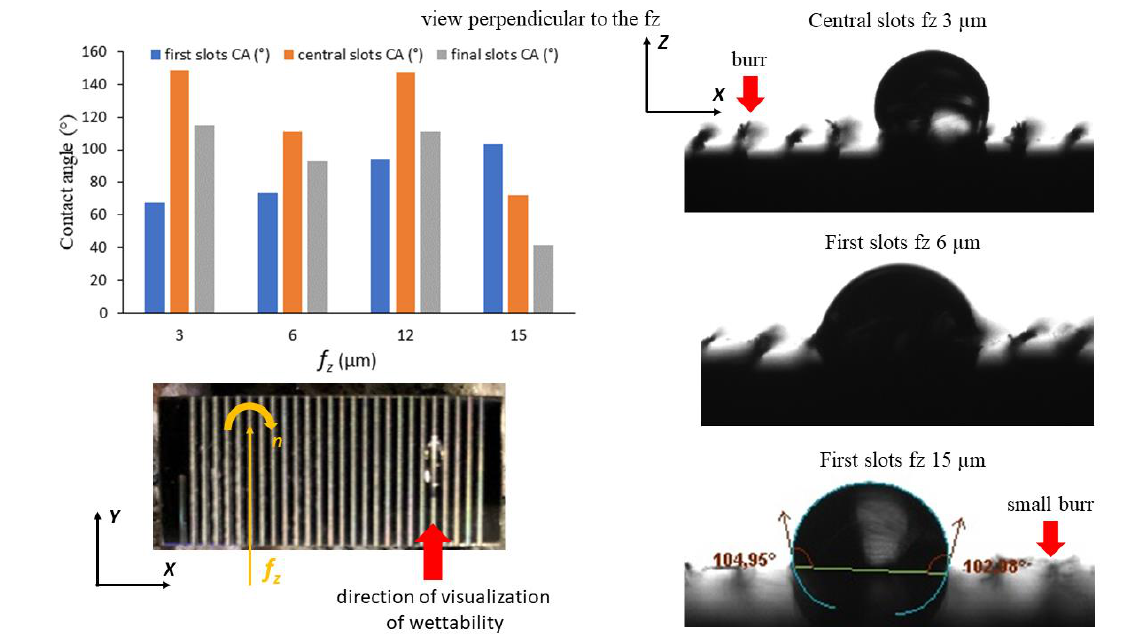
Figure 7: Contact angle depending on fz and the position of the channels. The displayed direction is perpendicular to the channel direction (front